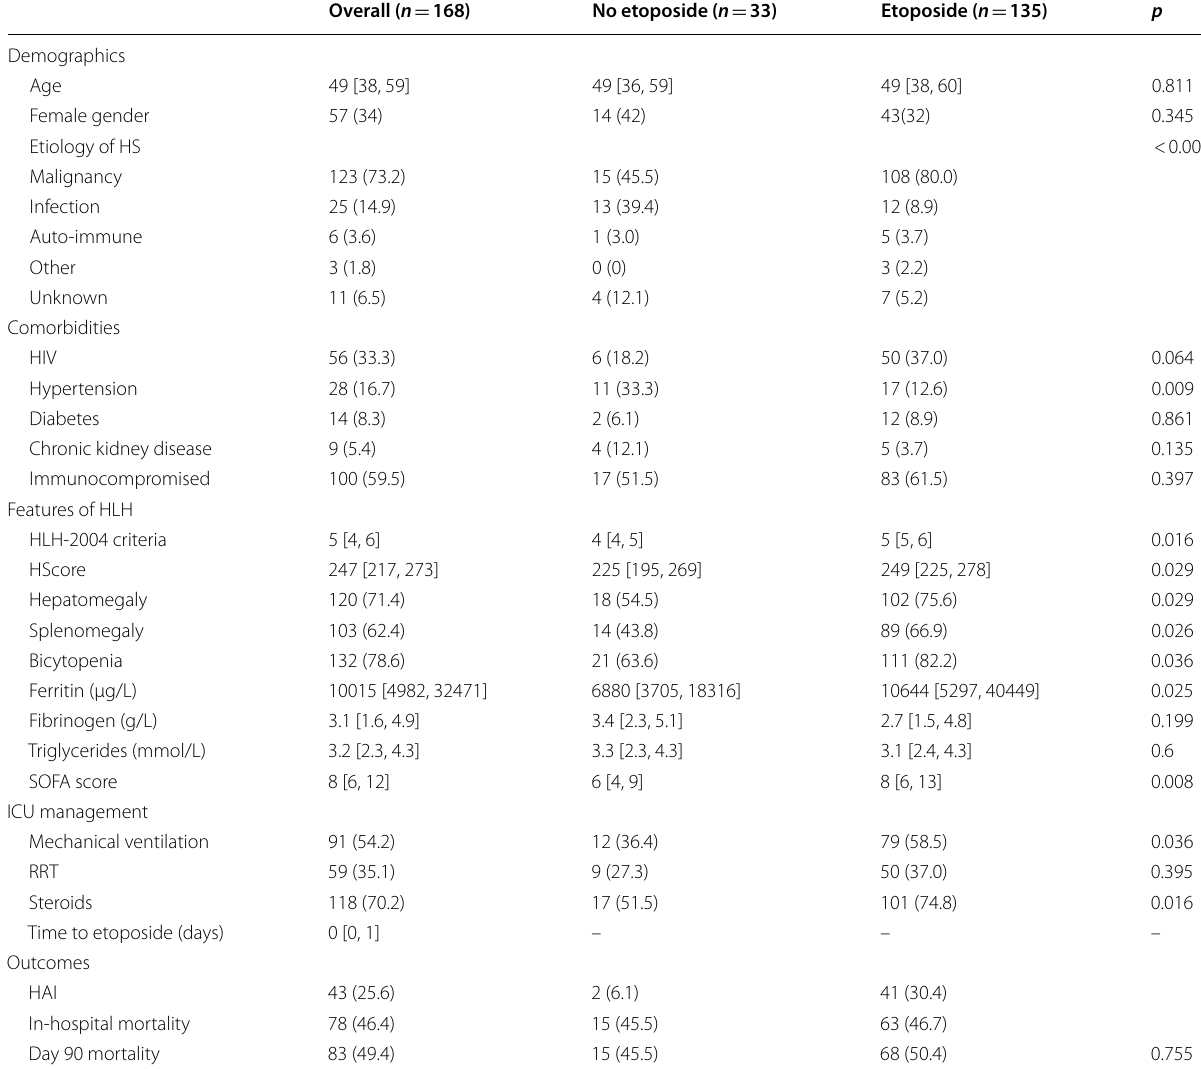
Values are given in N (%) for categorical variables or median [IQR] for continuous variables. Fisher’s exact test for categorical variables, and Kruskal–Wallis test for quantitative